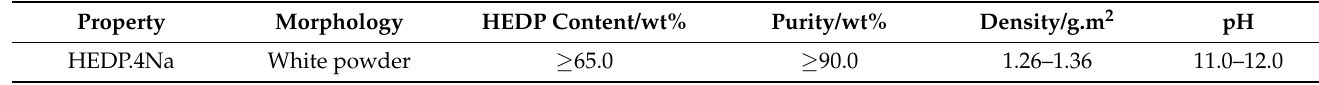
Table 1. Physical characteristics of HEDP.4Na.